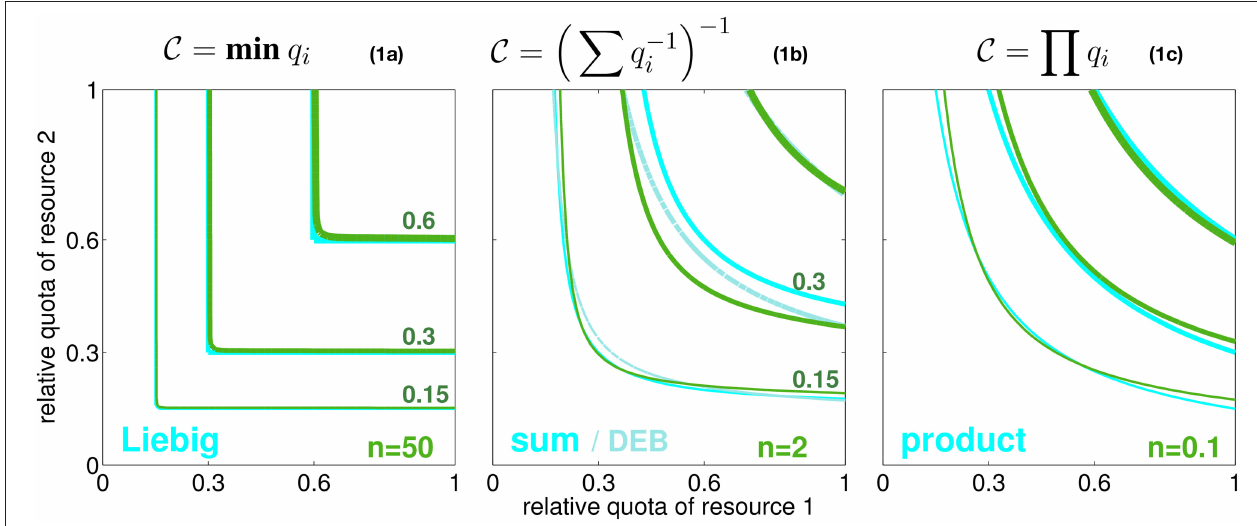
FIGURE 1 | Three idealized modes of co-limitation by two resources. From left to right: the Liebig, sum, and product formulation, both as growth-contour plots and respective formulae Equations 1a–c. Contour lines for C = 0.15, 0.3, and 0.6 are plotted with increasing line thickness as a function of the normalized quotas of q i , is given, which is proposed by the DEB theory (light cyan lines). The q − 1 i + 1 − elements 1 and 2 ( q 1 and q 2 ). Also a model similar to the sum rule, C − 1 = green contour lines show the co-limitation intensity C n according to Equation (2) with different values of the independence n as given in the P P